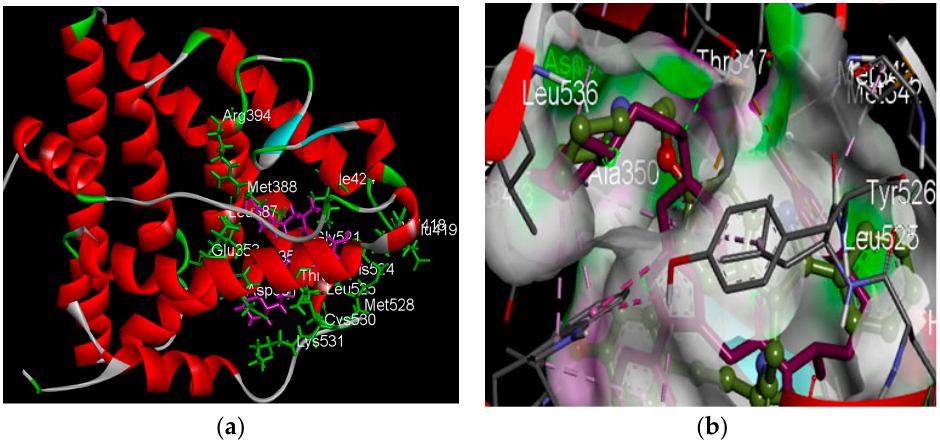
Figure 1. X-ray Structure of PDB ID 2IOG: ( a ) Target receptor, 2IOG with co-crystallized native ligand shown in purple sticks and amino acid residues shown as green sticks with their three-letter code and name; and ( b ) redooked native ligand superimposed with the crystallized native ligand within the binding pocket of 2IOG showing hydrogen bonding in white surface cartoon.